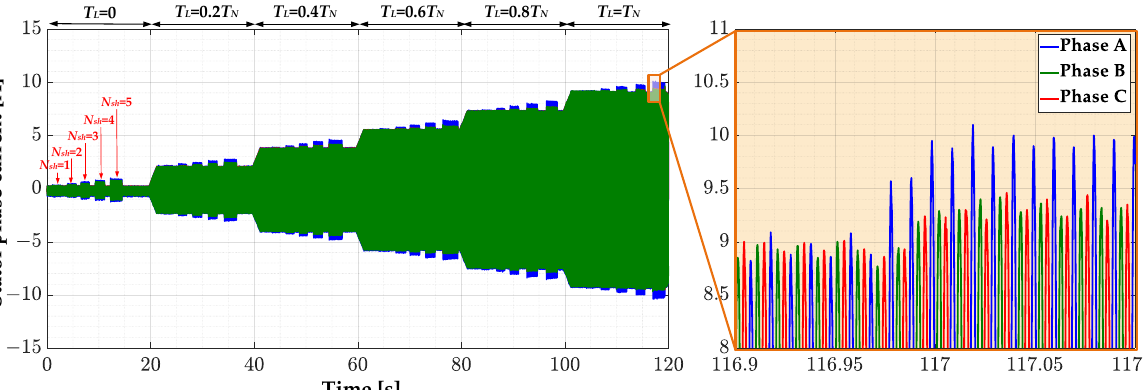
Figure 1. Effect of ITSCs in the PMSM stator winding on the waveforms of the stator phase currents, experimental study ( T L = var, f s = f sN = 100 Hz).